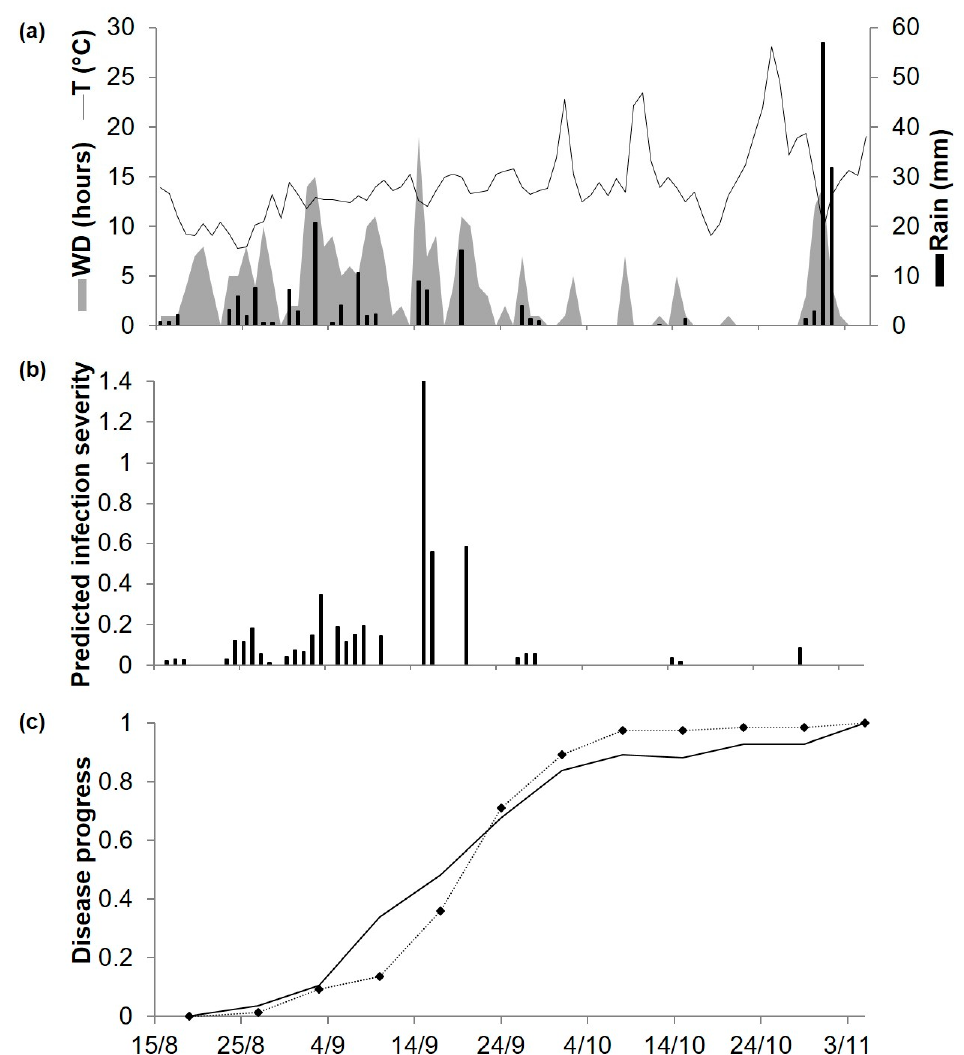
Figure 5. Predicted and observed disease progress (Ascochyta blight) on cv. Kaniva at the University of Adelaide’s Waite Campus, Australia, in 1997. ( a ) Weather variables: air temperature (T, °C, solid line), rainfall (Rain, mm, black bars), leaf wetness duration and (WD, hours, grey area). ( b ) Bars represent the infection severity predicted by the model. ( c ) Solid line represents the accumulated infection severity predicted by the model and rescaled to the final value of the year. Dotted line represents the accumulated value of Ascochyta blight severity rescaled final value of the year (80%).